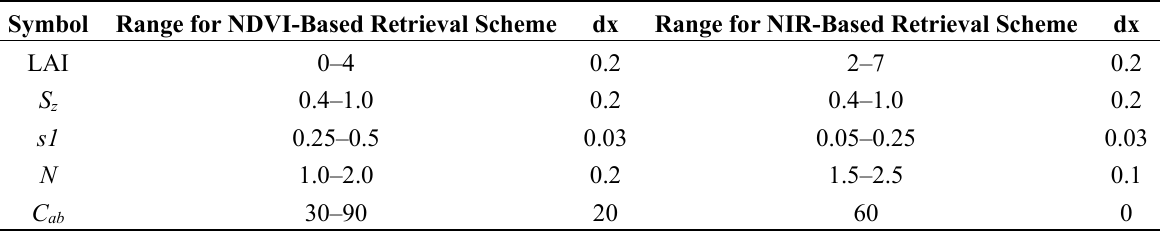
Table 2. Ranges and steps (dx) of sensitive parameters in the ACRM for the NDVI and NIR image-based retrieval